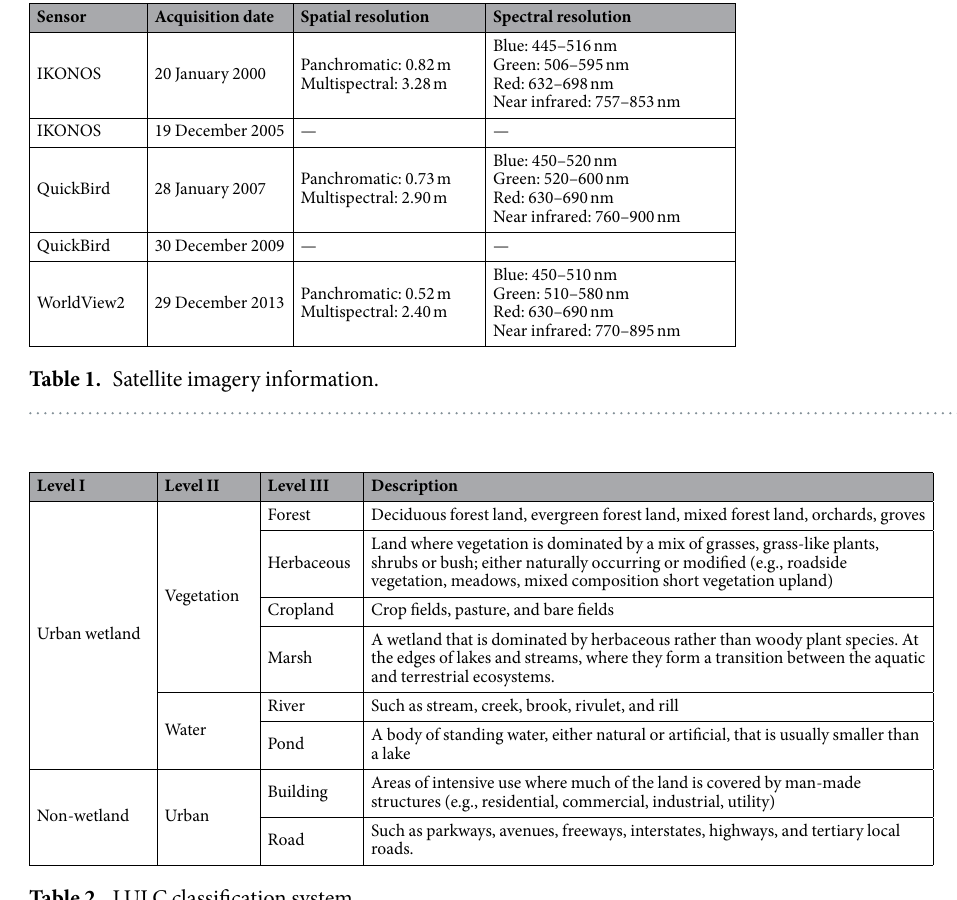
Table 2. LULC classification